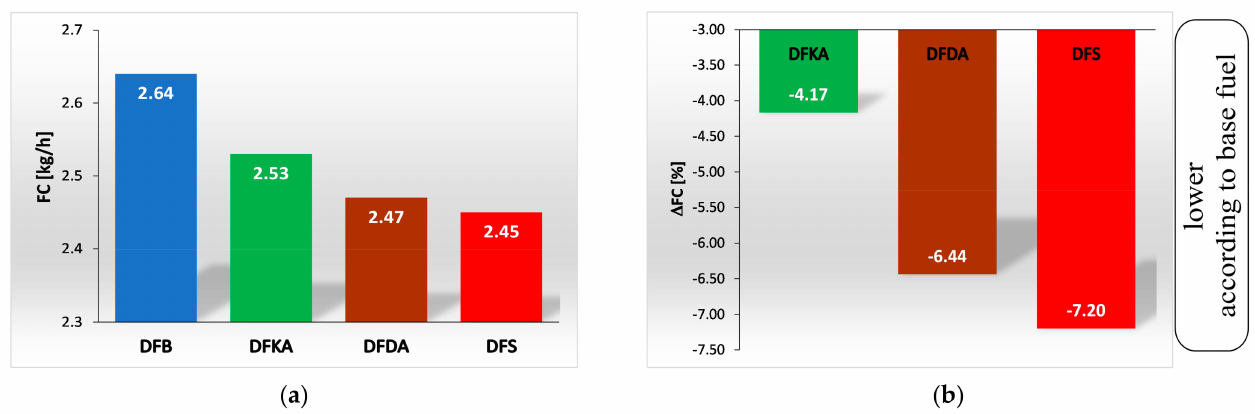
Figure 8. ( a ) Hourly fuel consumption (FC) for tested fuels. ( b ) Percent change in hourly fuel consumption ( ∆ FC) for tested fuels relative to FC for DFB (base